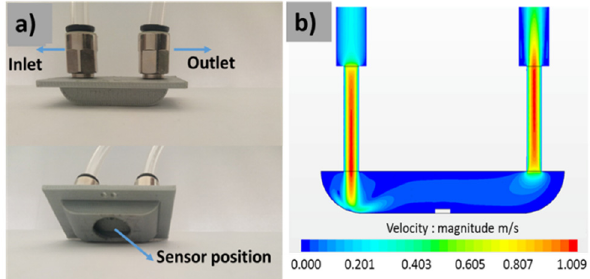
Figure 7 . ( a ) Testing chamber photographs and ( b ) the finite element simulation of the gas flow inside the chamber.